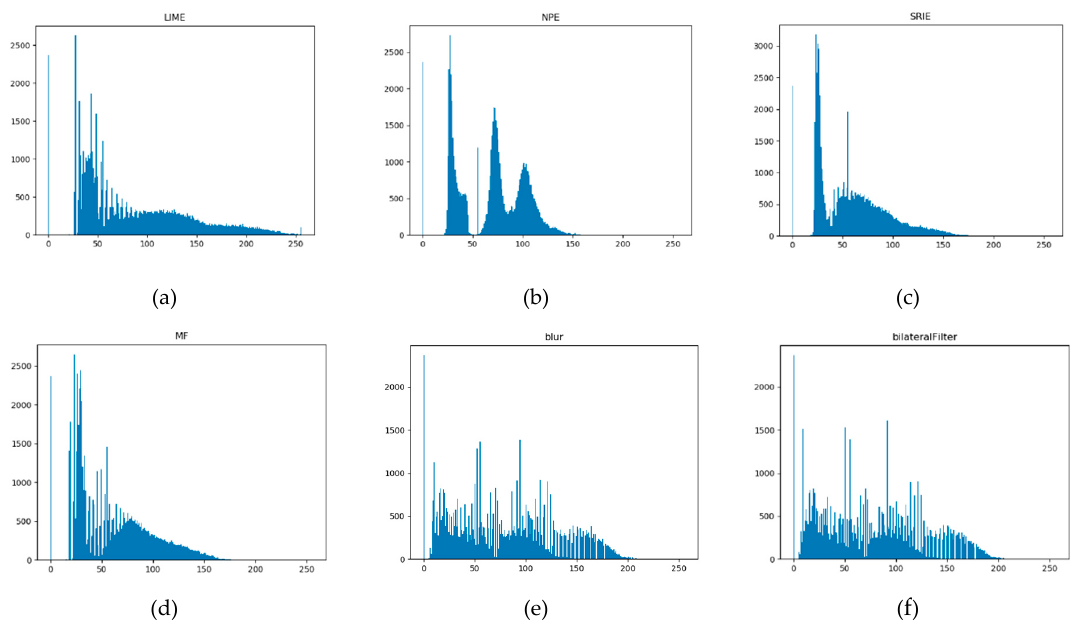
Figure 14. The histograms corresponding to Figure 13: ( a ) LIME, ( b ) NPE, ( c ) SRIE, ( d ) MF, and our